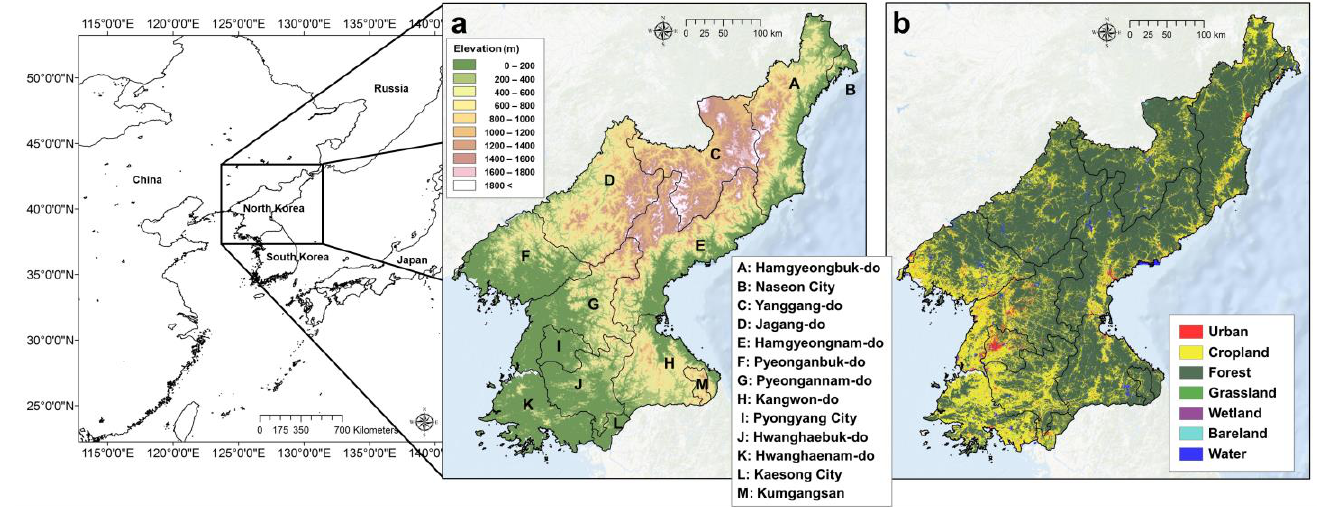
Figure 1. ( a ) Elevation of the study area with administrative boundaries (source: Mapzen Terrain Service) and ( b ) land cover in 2019 (source: Ministry of Environment, Korea).